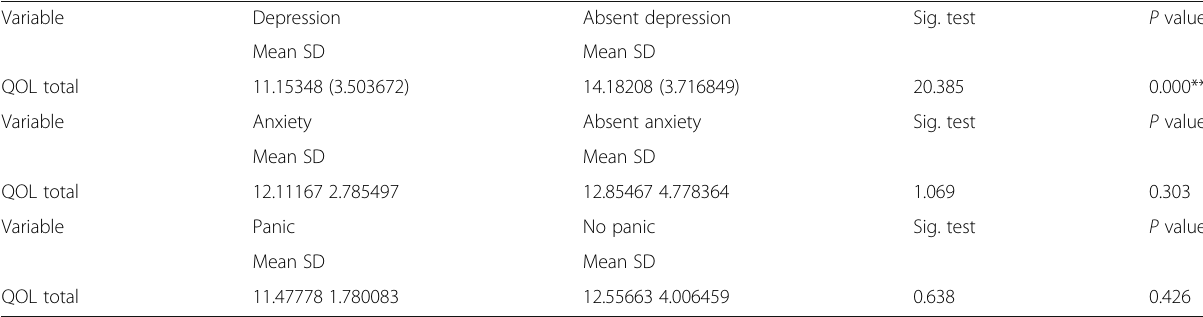
Table 4 Relation between QOL among patients with and without depression, anxiety, and suicidal ideations